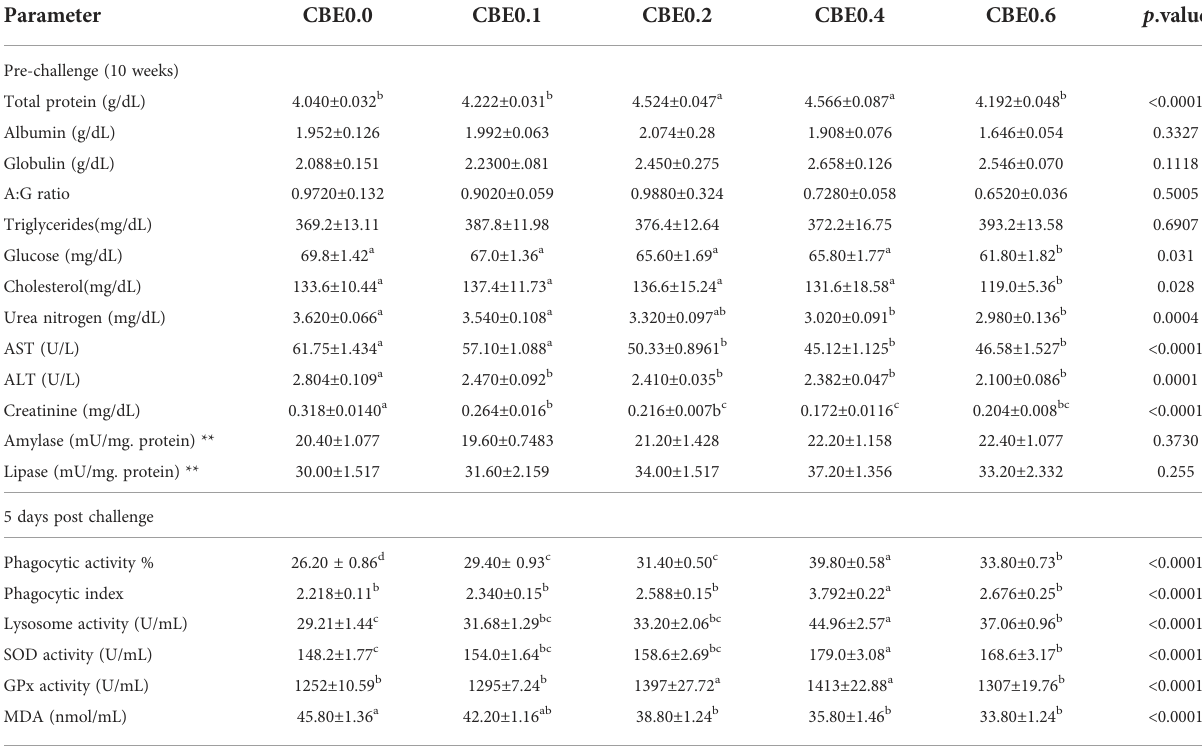
TABLE 6 Biochemical parameters of Nile tilapia ( Oreochromis niloticus ) reared for 10 weeks and fed on different doses of CBE.